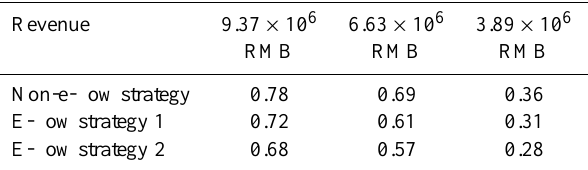
Table 4. Minimum degree of flow regime alteration under different planned revenues and different e-flow provision